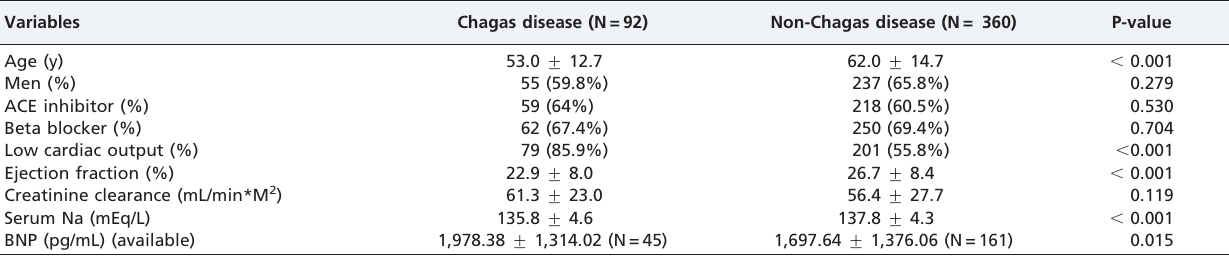
Table 2 - Univariate analysis according to etiology.